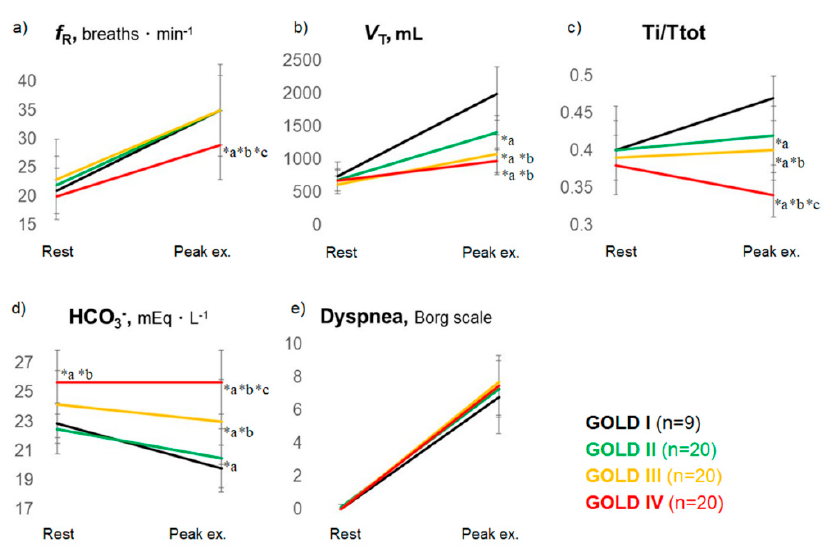
. Figure 2. Typical responses to incremental exercise by patients with chronic obstructive pulmonary disease. Data are presented as mean ± SD. ex.: exercise; f R : respiratory frequency; HCO 3- : bicarbonate ion; Ti/Ttot: inspiratory duty cycle; V ex: tidal volume. The 10-point modified Borg Scale, with 0 corresponding to no dyspnea and 10 corresponding to maximal dyspnea was used to evaluate the exertional dyspnea. Among the four Global Initiative for Chronic Obstructive Lung Disease (GOLD) stages, despite the different breathing patterns (( a ): f R , ( b ): V ex, and ( c ): Ti/Ttot) during exercise, patients with COPD did not regulate the exertional acidosis (( d ): HCO 3- ) to stop exercise, reaching a similar exertional dyspnea level ( e ). Using the Kruskal–Wallis test to compare the groups consisting of the four GOLD stages, there was a significant difference in f R ( p = 0.0021), V T ( p < 0.0001), Ti/Ttot ( p < 0.0001), and HCO 3- ( p < 0.0001) at peak exercise, and HCO 3- ( p < 0.0001) at rest. Using the Steel–Dwass test to carry out between-group comparisons, *a, p < 0.05 versus GOLD I; *b, p < 0.05 versus GOLD II; *c, p < 0.05 versus GOLD III. This is an original figure (no permission is required).